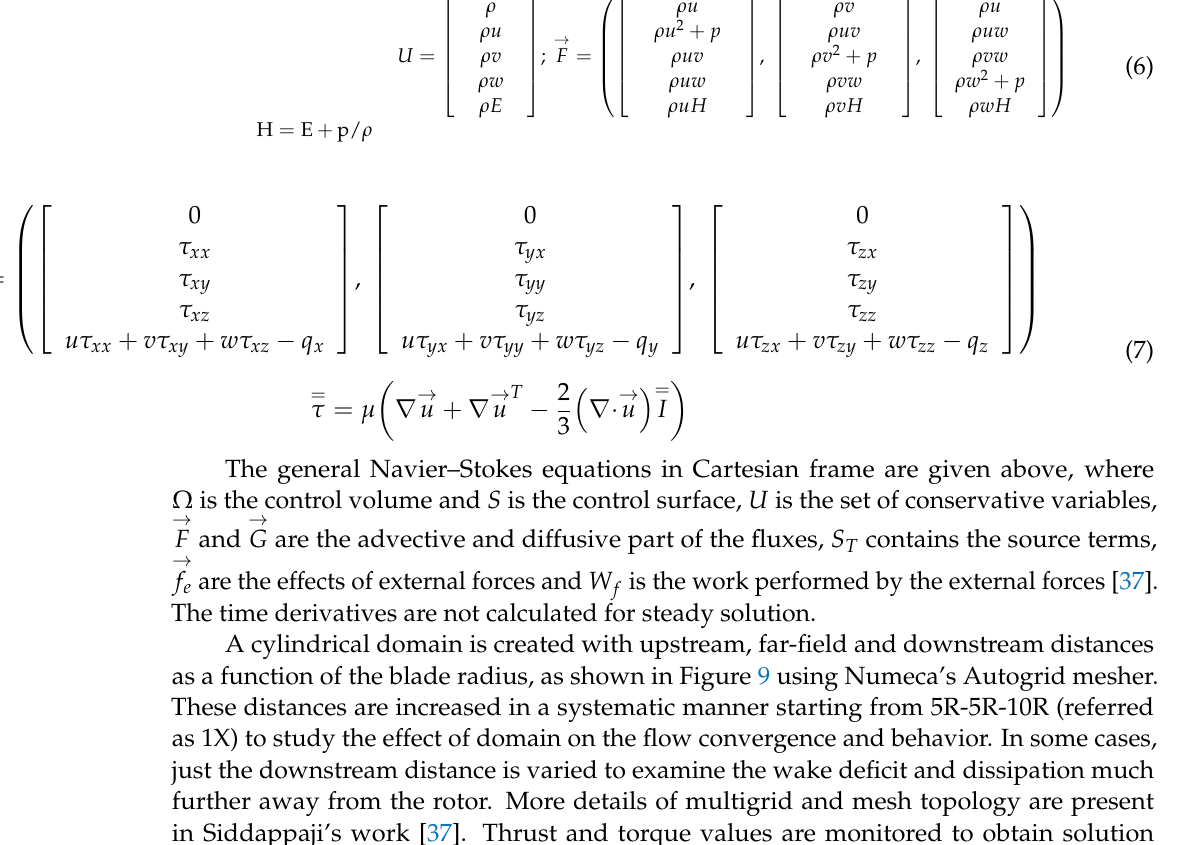
Figure 9. A 2-bladed solo propeller 3D blade shape with a typical domain showing convergence by tracking thrust and torque values. A grid-dependency study is performed with y (cid:2878) values of these blades between 1–8 indicating good quality of mesh for flow analysis to ensure the accuracy of the solution. Figure 10 shows three levels of grid density with thrust and torque values for various levels, demonstrating that after a certain number of grid points these values do not change significantly. Axisymmetric meshes for several domain sizes are compared in Figure 11a, keeping the region around the blade dense and similar across the domain sizes and sparse downstream. A typical mesh around the blade for domain 1X is shown in Figure 11b. 4X_AGS domain size is chosen for the grid-dependency study of the propeller design and for further flow analysis. Mass averaged absolute velocity magnitude for the corresponding domains in azimuthal (axisymmetric) views are also shown in Figure 11a, which demonstrates that a longer downstream domain is essential to capture the flow behavior since it takes longer than 5D to mix out to the upstream velocity.